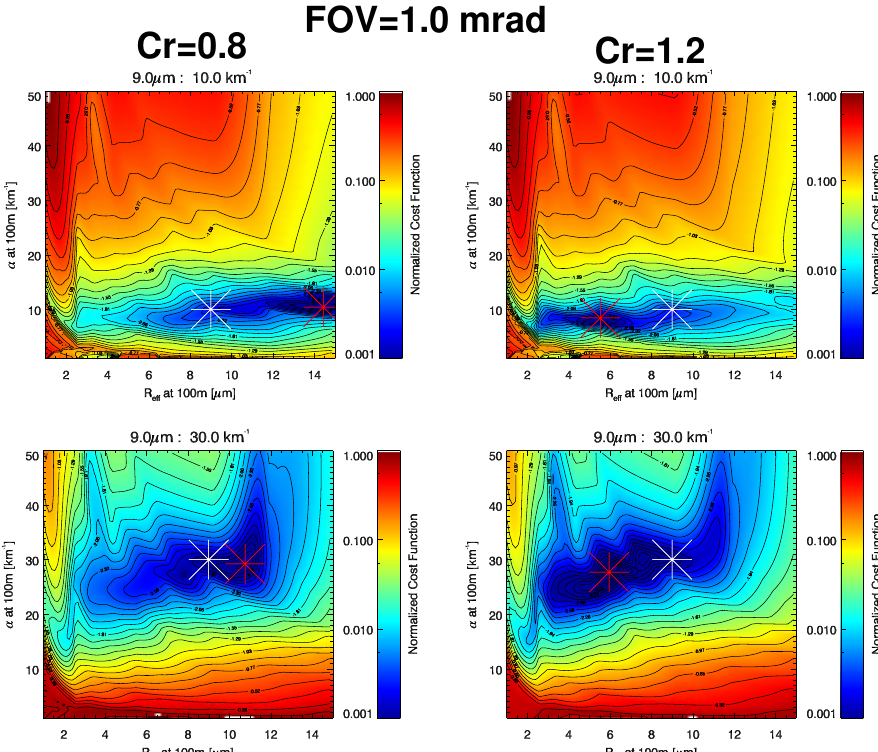
Figure 7. Normalised results from the application of Eq. (20) as a function of α 100 ,k and R eff,100,k for true values of α 100 = 10 and 30km − 1 and true values of R eff,100 = 9µm with perturbed values of C r . For the left panels C r has been set 20% too low while in the right panels C r has been set 20% too high. The white symbols show the location of the true values of R eff,100 and α 100 while the red symbols mark the position of the actual cost-function minimum in each